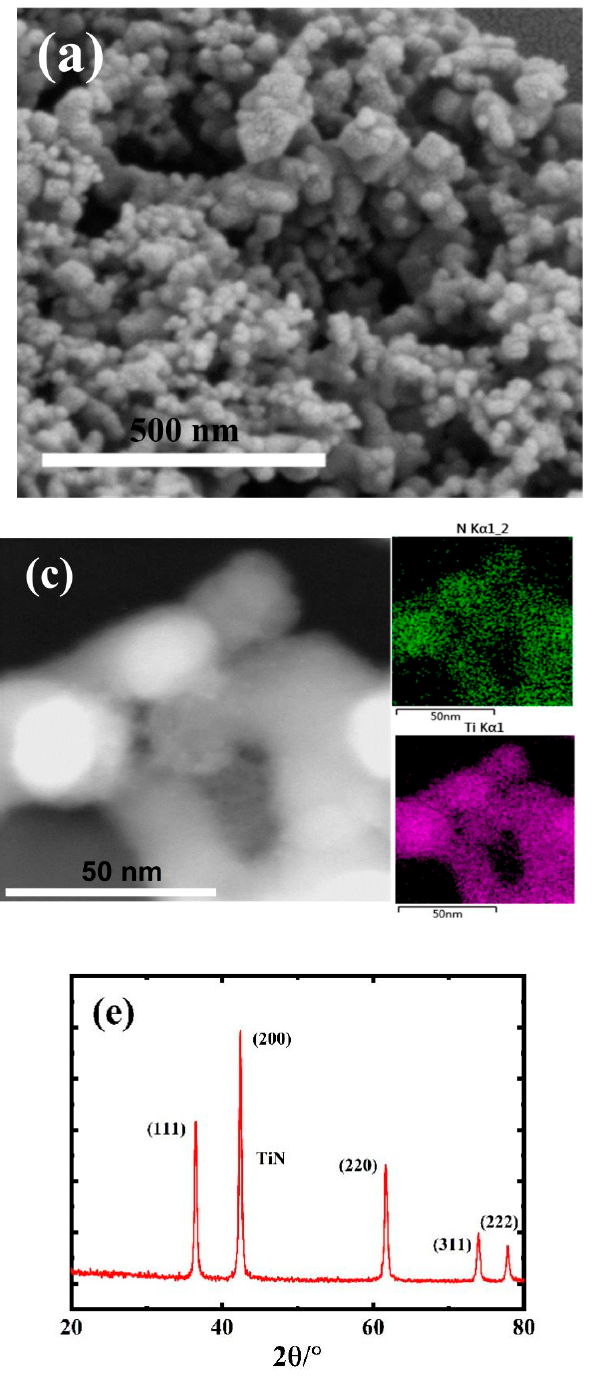
Figure 1. ( a ) SEM image. ( b ) TEM image. ( c ) EDX mapping result. ( d ) Linear optical absorption behavior. ( e ) XRD pattern and ( f ) DLS analysis of TiN QDs.